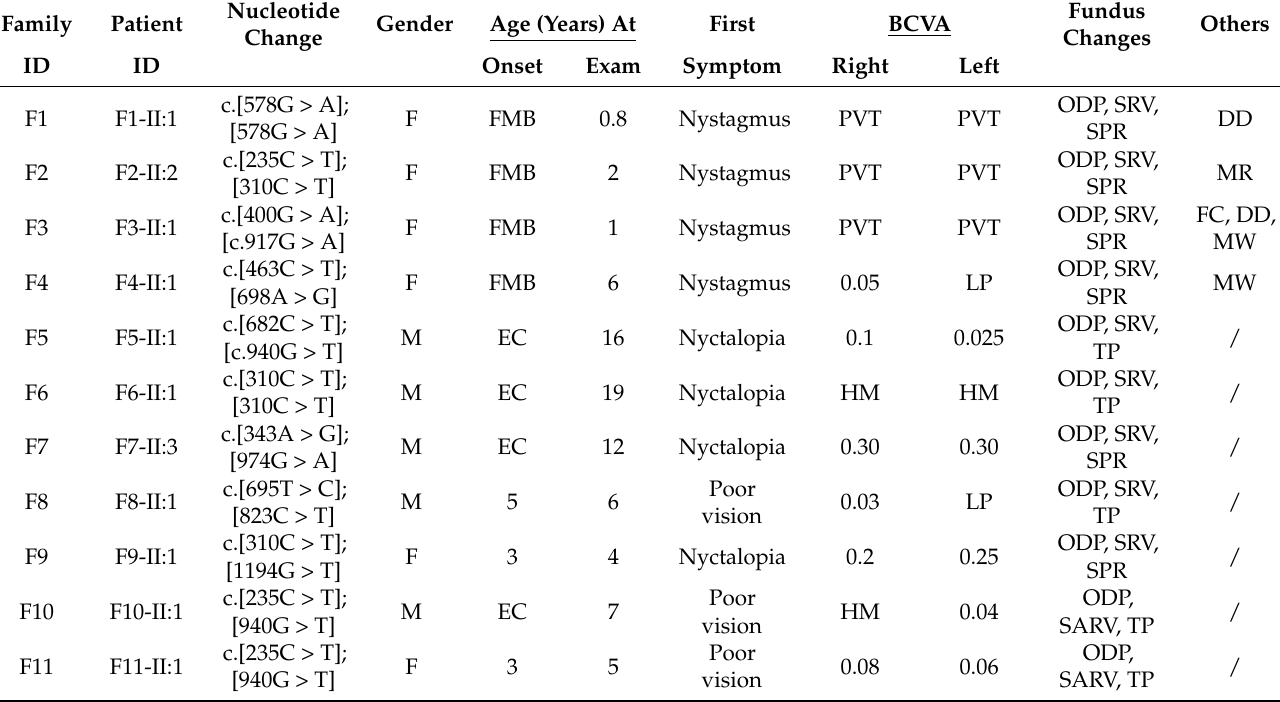
Table 2. Clinical information of the eight patients with biallelic FDXR